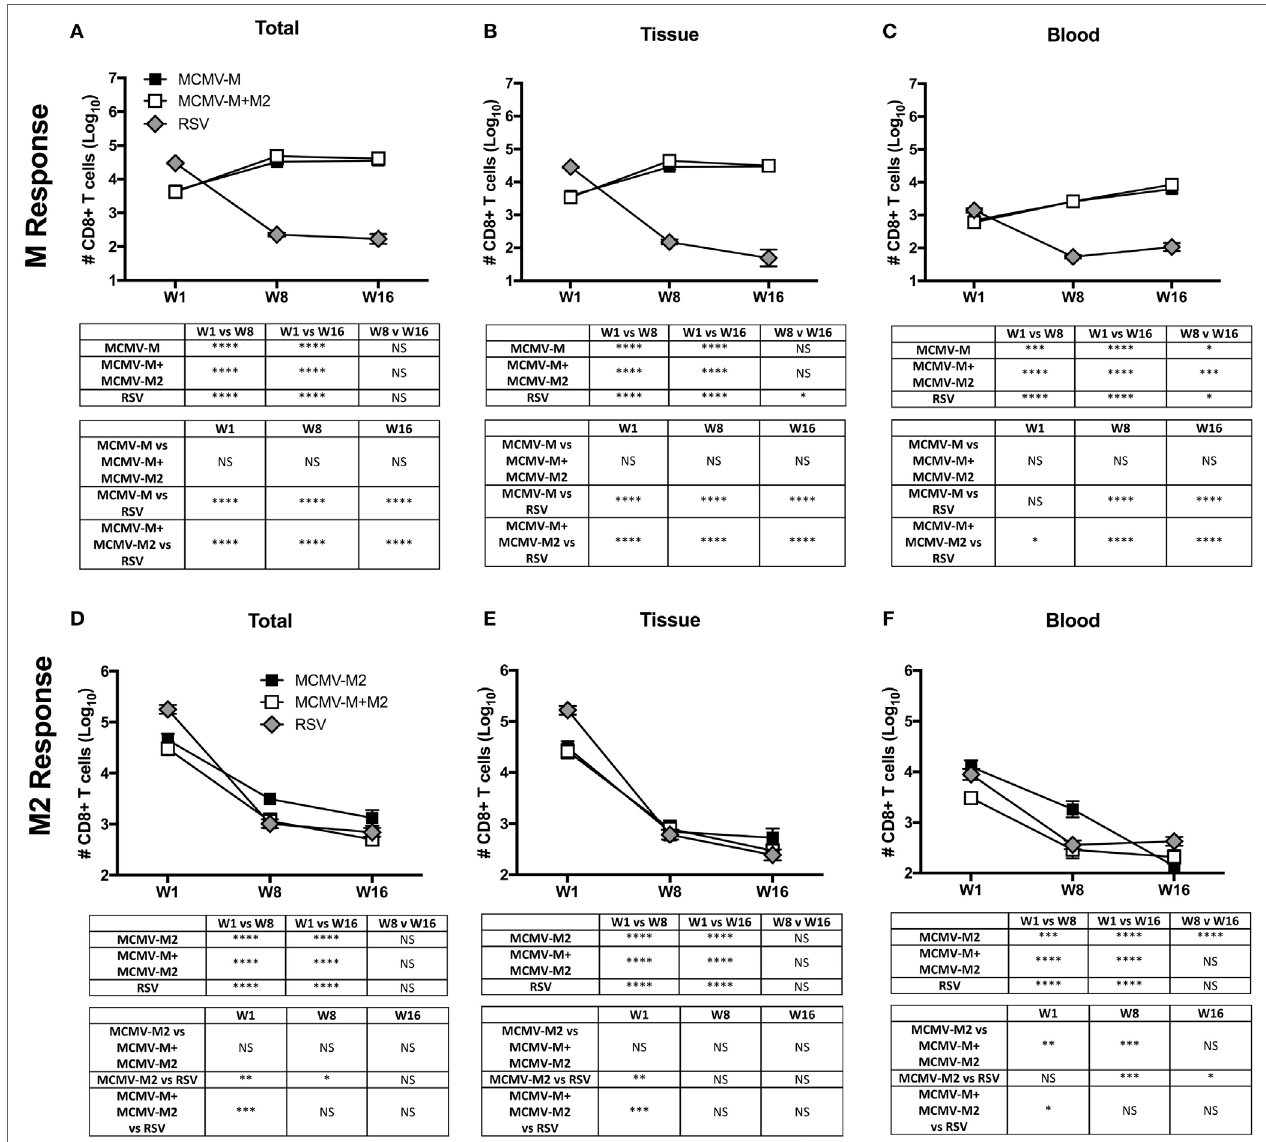
FigUre 2 | The M-specific CD8 + T cell population inflates, whereas the M2-specific CD8 + T cell population contracts, after vaccination with murine cytomegalovirus (MCMV) . (a–F) Mice were infected with respiratory syncytial virus (RSV) or vaccinated with MCMV-M or MCMV-M2 alone or a combination of MCMV-M and MCMV-M2 via the intranasal route. Intravascular staining was used in conjunction with D b /M 187–195 and K d /M2 82–90 tetramers to quantify M-specific (a–c) and M2-specific (D–F) CD8 + T cells in the lung tissue and blood at weeks 1 (W1), 8 (W8), and 16 (W16). Total (a,D) denotes all tetramer + CD8 + T cells regardless of location. Bars indicate mean ± SEM ( n = 5 mice/group). **** P < 0.0001, *** P < 0.001, ** P < 0.01, * P < 0.05 by two-way ANOVA. Data are shown from one experiment and representative of two independent